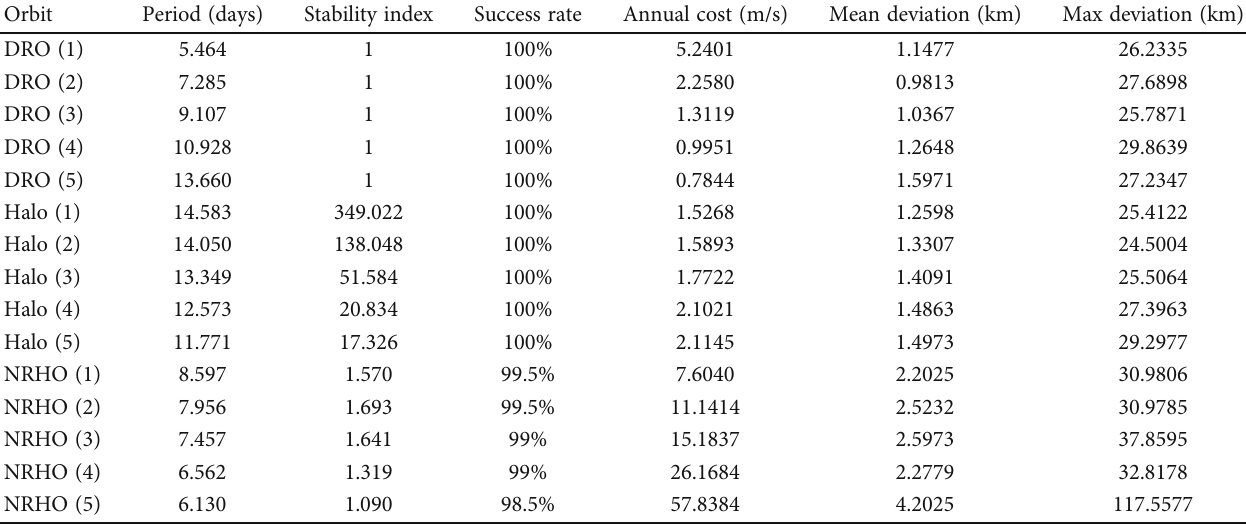
Table 6: The performance indexes of the station-keeping simulations for all nominal orbits.